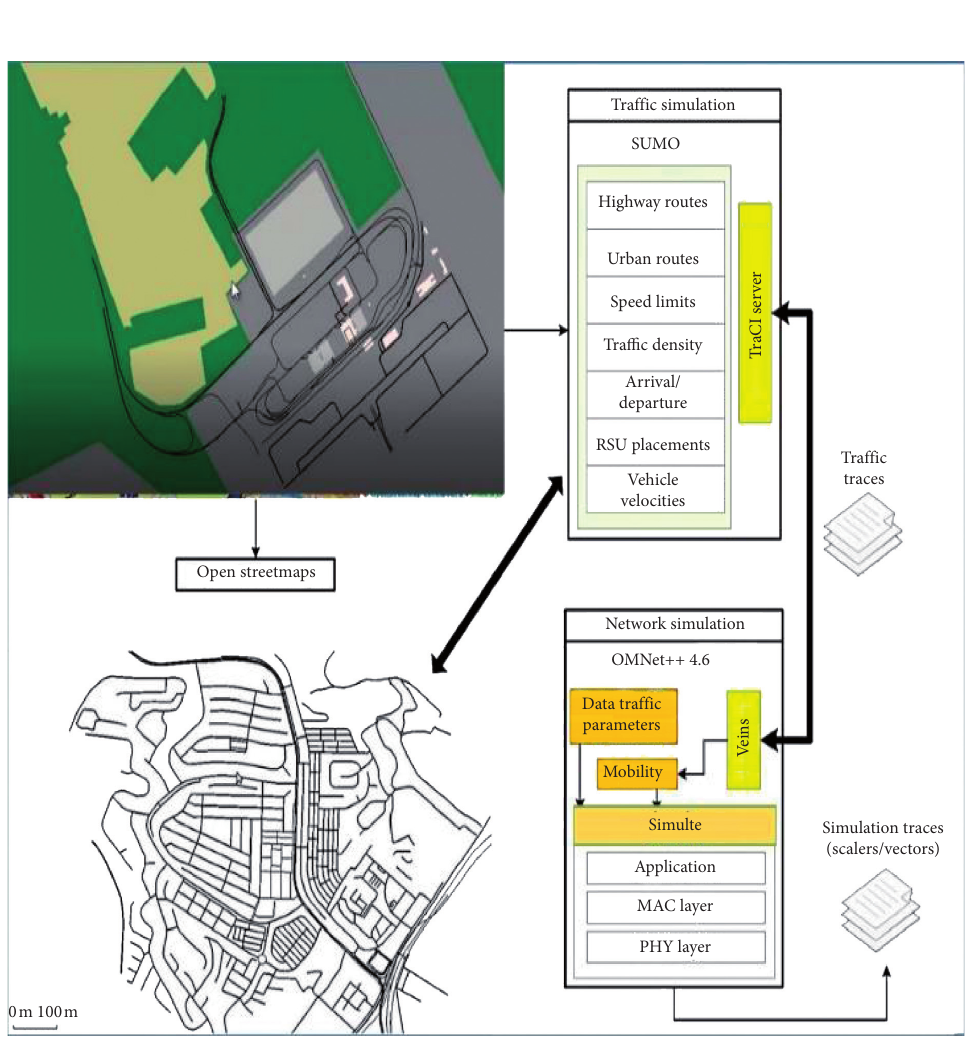
Figure 4: Simulation and evaluation